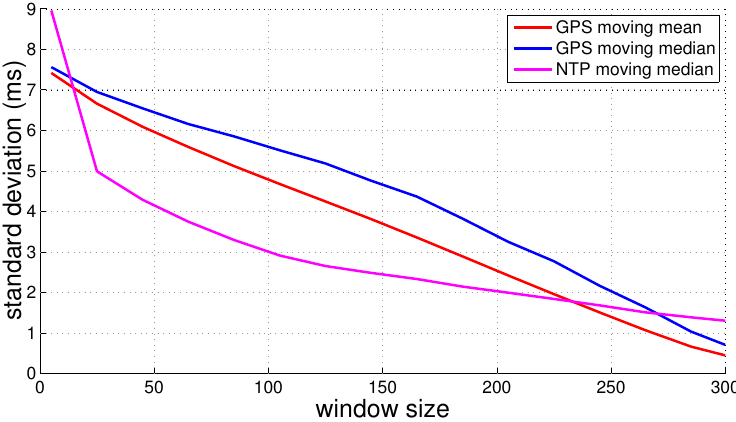
Figure 8. Standard deviation of the clock offset, varying the window size for GPS and